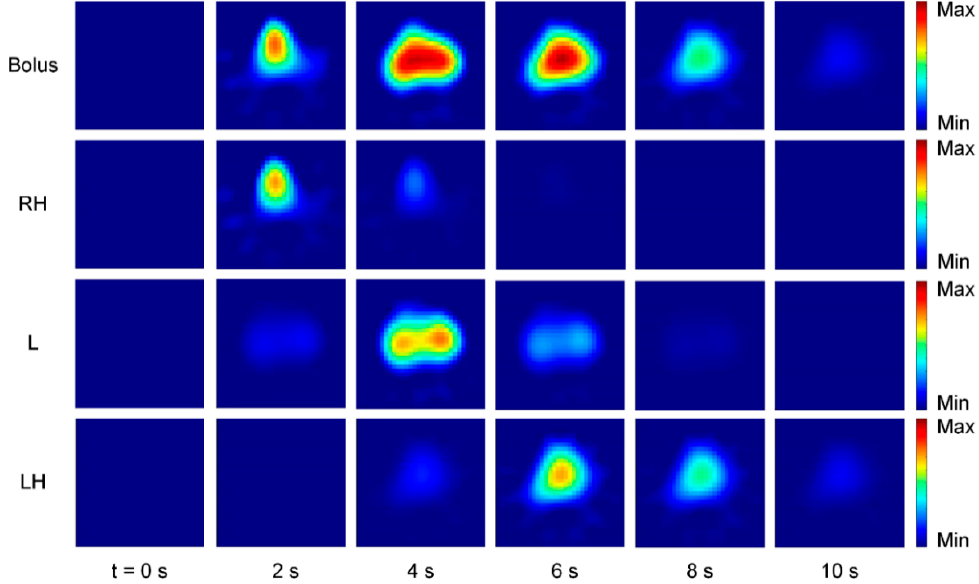
Figure 5. Bolus injection and transport of contrast agent (NaCl 10%) through the cardio-pulmonary system. The bolus is injected at t = 0 s and transported from the right heart (RH) to the lung (L) into the left heart (LH). Separation of the bolus is achieved using gamma-variate model fitting.